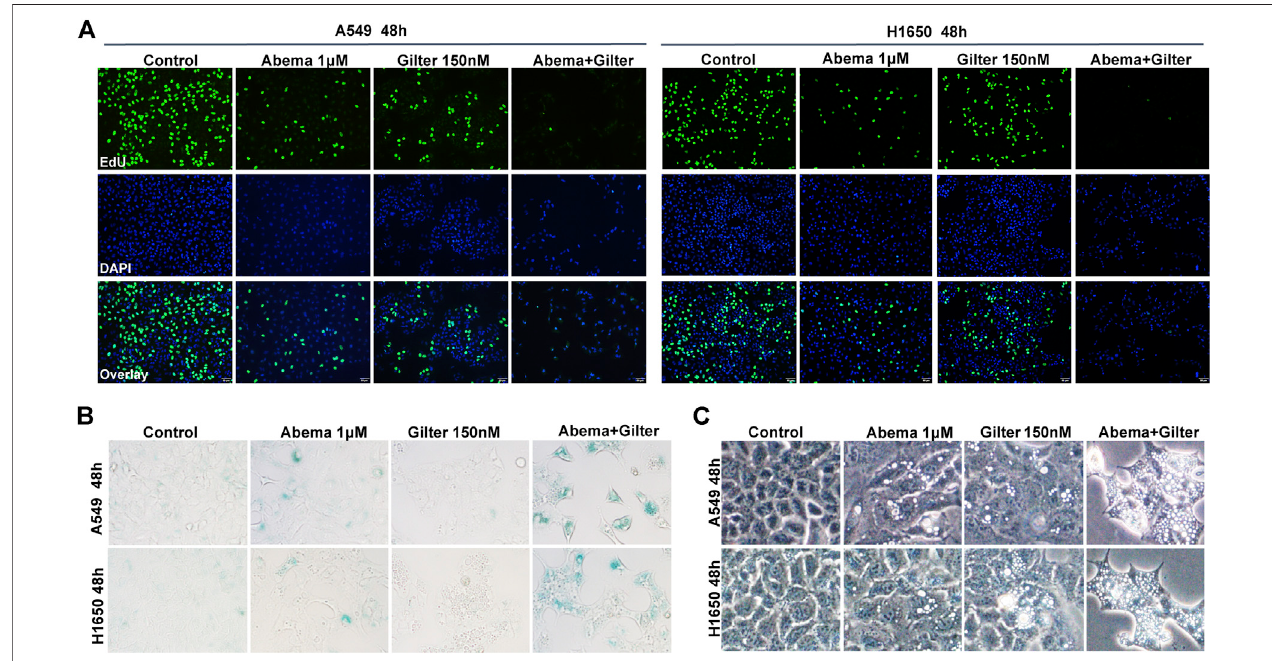
FIGURE2 | Abemaciclib in combination withgilteritinib inhibits cell proliferation, induces senescence and vacuoles in lung cancer cells (A) A549, H1650 cells were treated by 1 μ M abemaciclib, or 150 nM gilteritinib, or in combination, and cell proliferation was determined by the EdU assay (B) A549, H1650 cells were treated by 1 μ Mabemaciclib,or150 nMgilteritinib,ortheircombination,andtheSA- β galstainingkitwasusedtodetectcellsenescence (C) A549andH1650cellsweretreatedby 1 μ M abemaciclib, or 150 nM gilteritinib alone, or the combination, and cellular morphology was observed using microscope. Data are representative of at least three independent